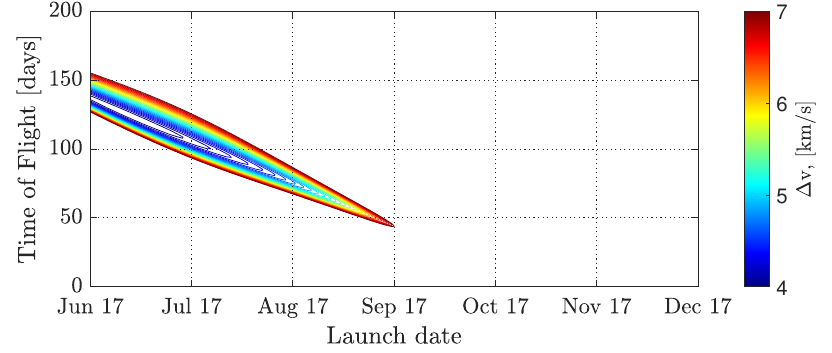
Figure 5. Porkchop plot of the launch windows for the ’Oumuamua interception starting from the vicinity of L1 in the June–December 2017 interval. Both axis are measured in days and ∆ v in km/s.